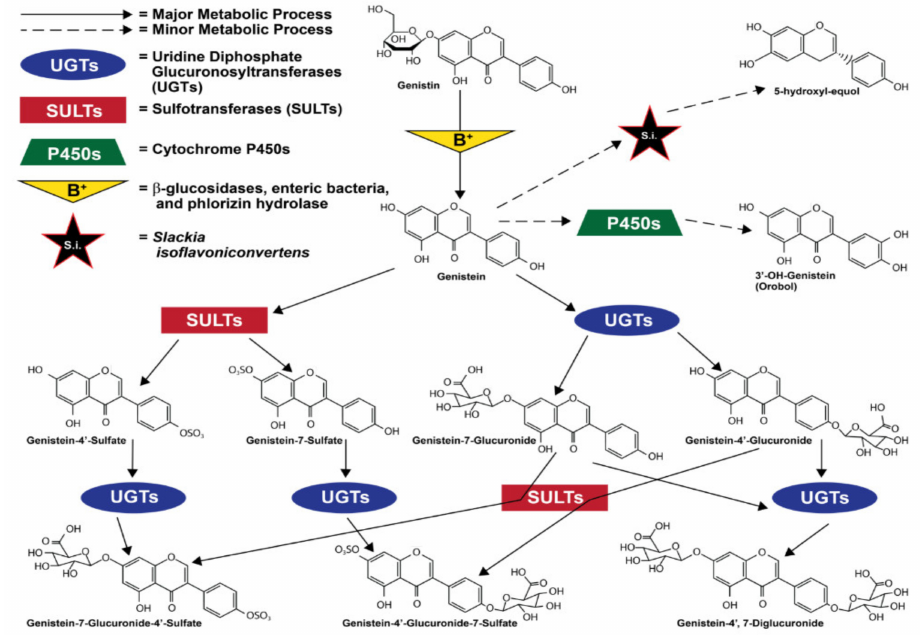
Figure 2. Major genistein metabolites. Data from [79,82,86–89]. Structures from